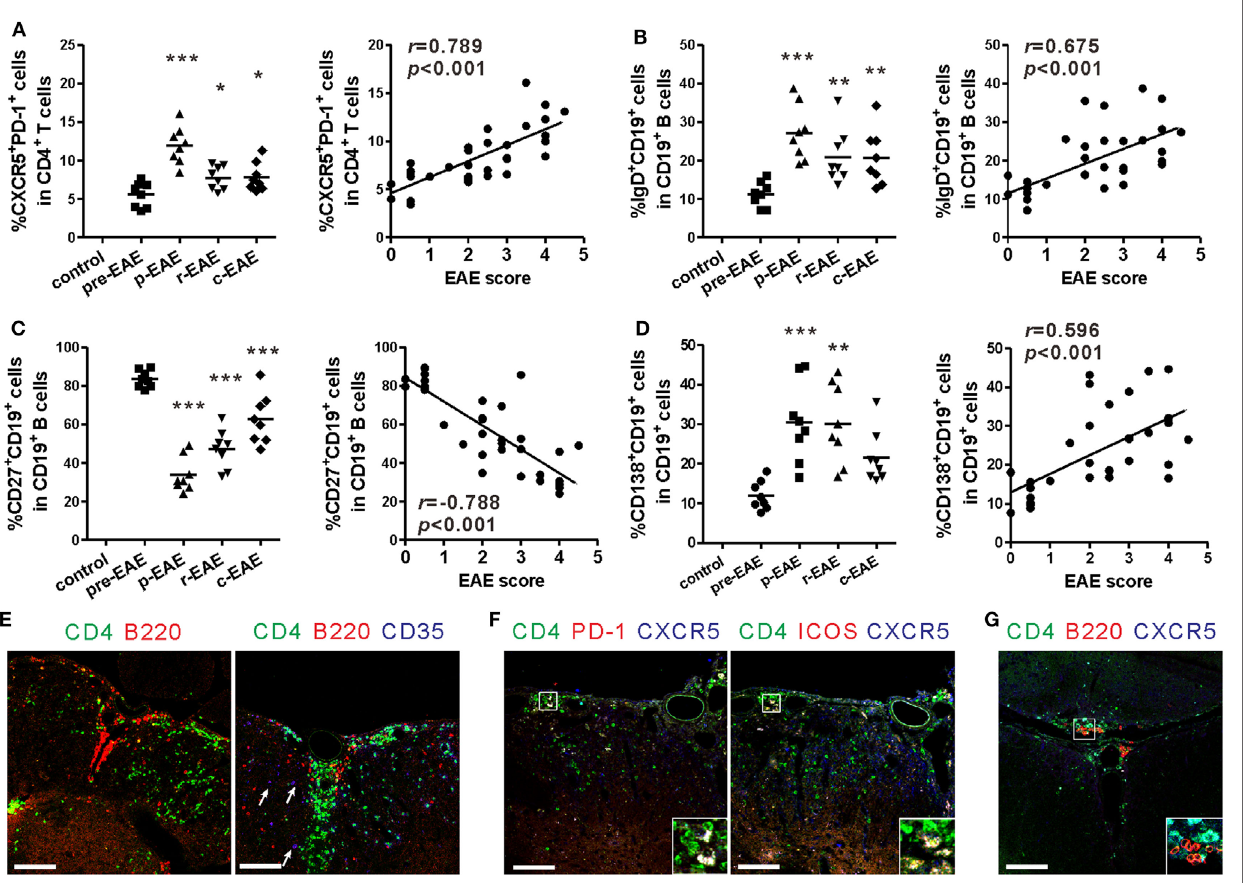
FigUre 4 | T follicular helper (Tfh)-like and B cells entering into the central nervous system (CNS). (a) Comparison of the frequency of Tfh-like cells in the CNS (spinal cord and brain) of experimental autoimmune encephalomyelitis (EAE) mice at different phases (left) and its correlation with EAE score (right). (B) Comparison of the frequency of mature B cells in the CNS (spinal cord and brain) of EAE mice at different phases (left) and its correlation with EAE score (right). (c) Comparison of the frequency of memory B cells in the CNS (spinal cord and brain) of EAE mice at different phases (left) and its correlation with EAE score (right). (D) Comparison of the frequency of plasma cells in the CNS (spinal cord and brain) of EAE mice at different phases (left) and its correlation with EAE score (right). For (a–D) , each data point represents an individual subject and the horizontal lines represent the means ( n = 8/time point). Results are representative of three independent experiments. Abbreviations: Pre, pre-clinical; P, peak; R, remission; C, chronic. * P < 0.05, ** P < 0.01, *** P < 0.001 vs. Pre. (e) ELSs and germinal center (GC)-like structures forming in the spinal cords of EAE mice at peak phase (12–20 dpi, score 4–5). Arrows show CD35 + follicular dendritic cells. (F) Tfh-like cells infiltrated into the spinal cords of EAE mice at peak phase (12–20 dpi, score 4–5). (g) Tfh-like cells co-localized with B cells in the spinal cords of EAE mice at peak phase (12–20 dpi, score 4–5). Sections are representative of three mice analyzed. Bar = 100 μ